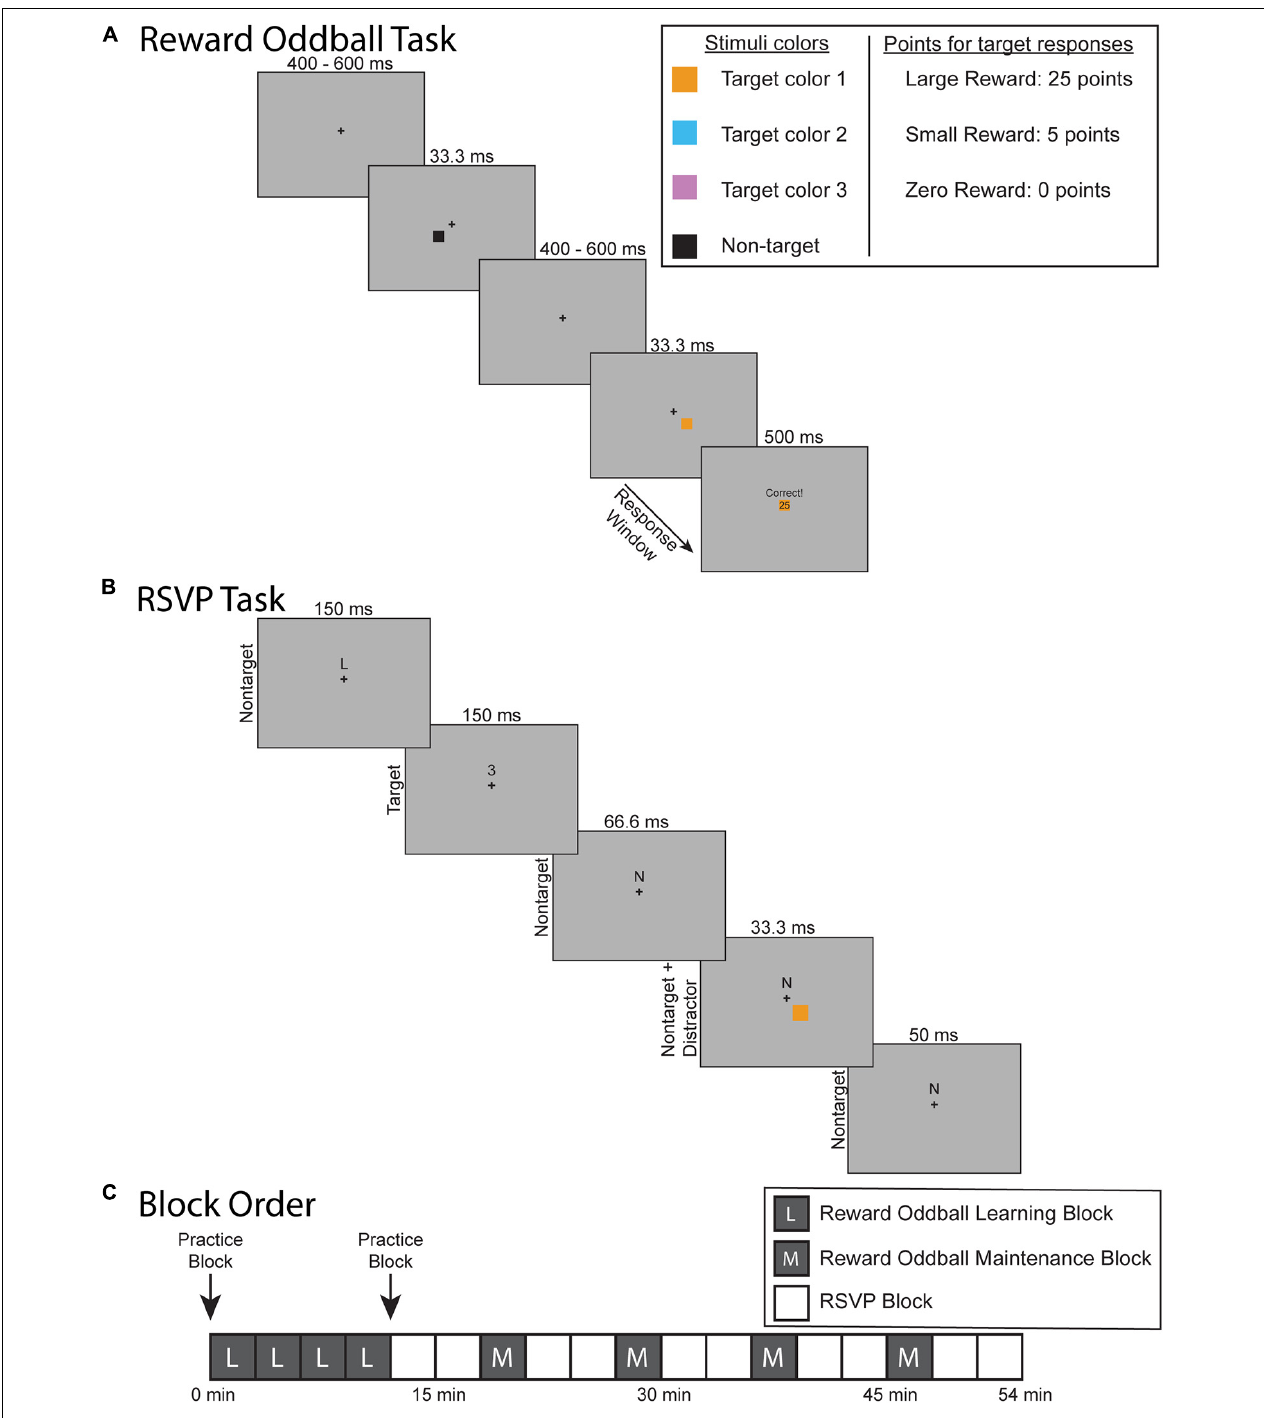
FIGURE 1 | Experiment and protocol design. (A) Reward oddball task. Participants responded to the location of colored, lateralized target. Accurate and sufficiently fast responses would be rewarded with points that were later converted into a monetary bonus. (B) The rapid serial visual presentation (RSVP) task. Participants fixated on a cross at the center of the screen while covertly attending to a stream of letter and number characters slightly above fixation – and pressing a button whenever a number character appeared (8% of the character stimuli). Periodically during this task, one of the lateralized colored squares would reappear on the screen as a reward-associated distractor. (C) Overview of the experimental protocol. The experiment began with four blocks of the reward oddball task so that participants learned to associate each colored square with different levels of reward. They then completed the RSVP task to test how these reward-associated distractors impacted sustained spatial attention. The RSVP task blocks were then interleaved with blocks of the reward oddball task in order to maintain these reward associations.